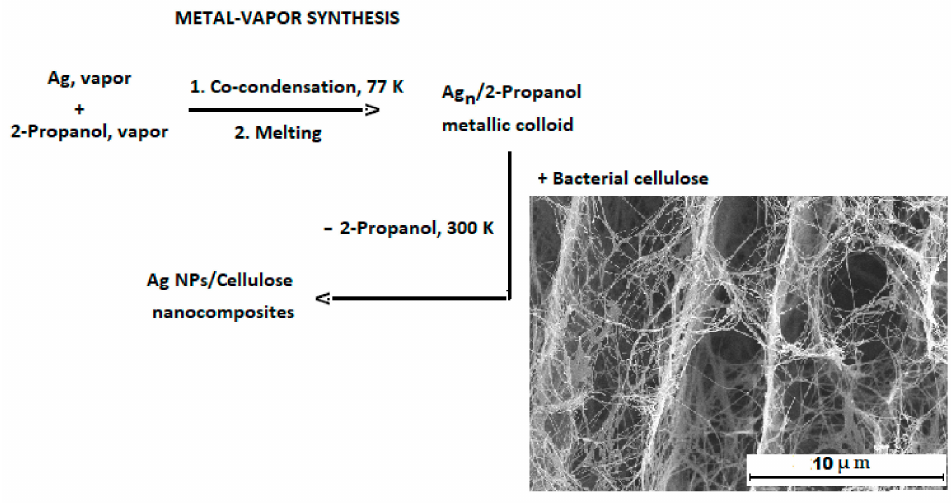
Figure 3. Synthesis of Ag-containing nanocomposites.